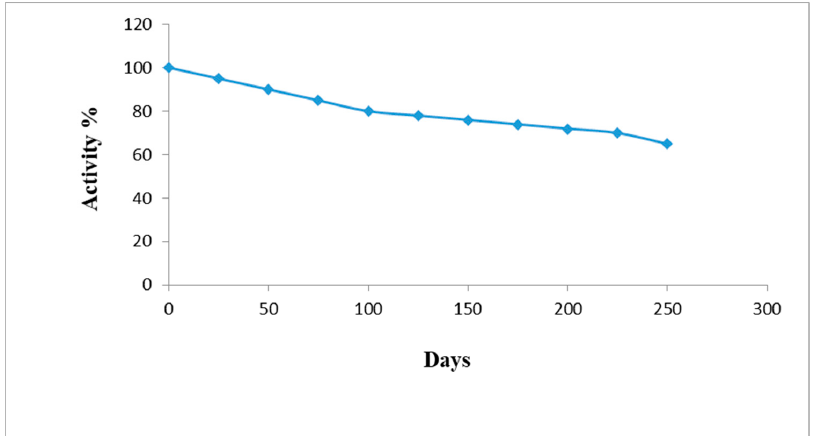
Figure 11. Storage stability of AChENPs/ChONPs/GONS/PtNPs/PGE at 4 ◦ C in dry condi- tion. (AChENPs = Acetylcholine esterase nanoparticles; ChONPs = Choline oxide nanoparticles; GONS = Graphene nanosheets; PtNPs = Platinum nanoparticles; PGE = Pencil graphite